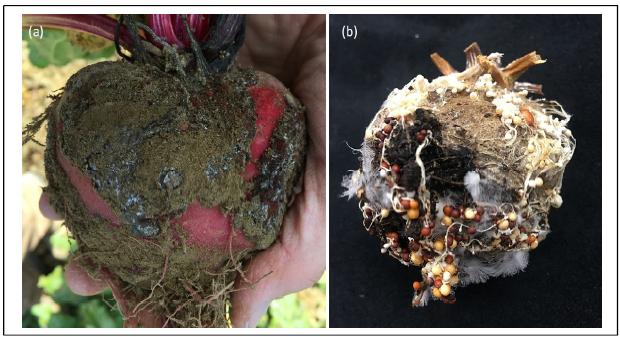
Figure 5. Symptoms of ( a ) Common scab caused by Streptomyces spp.; and ( b ) Southern Sclerotium root rot caused by Athelia rolfsii , are important soilborne diseases of table beet in New York with limited geographical distributions. Figure 5a provided with permission by A. Ivy, Cornell Cooperative Extension, New York, USA.